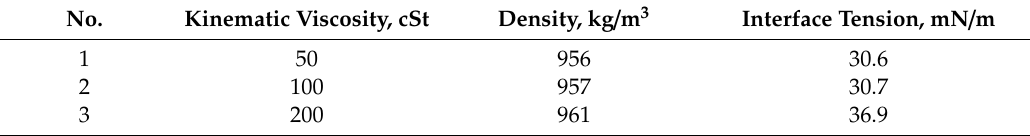
Figure 1. Experimental setup. Table 1. Properties of the silicone oils used in the